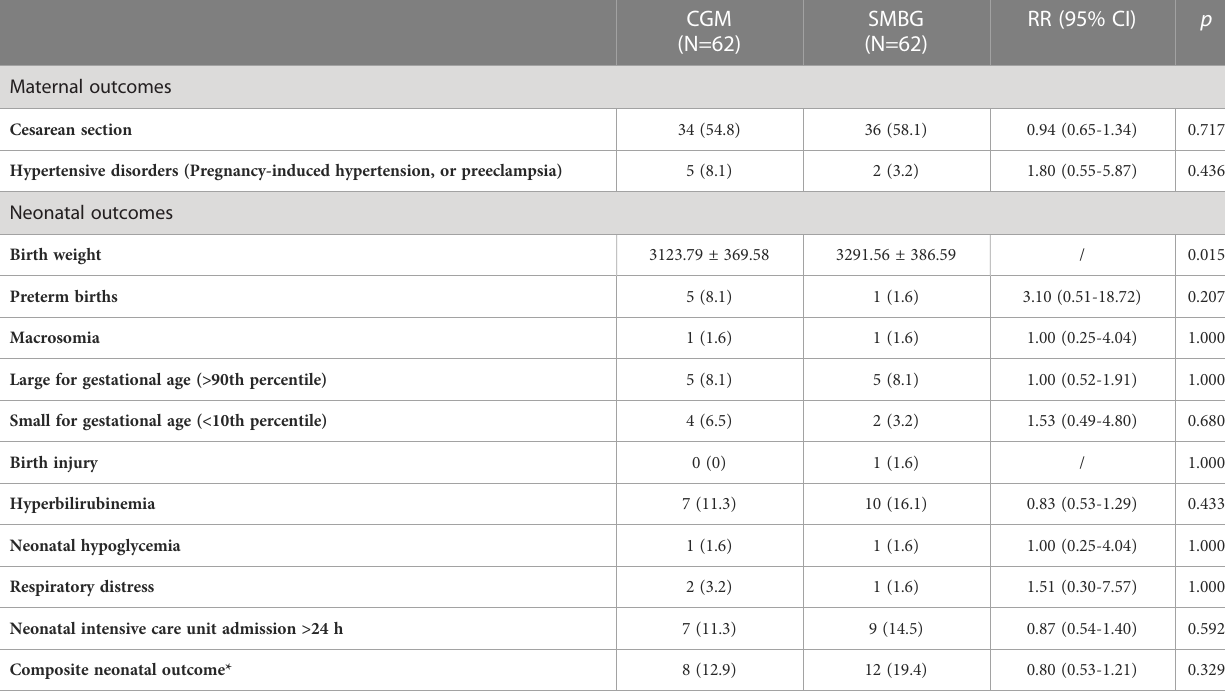
TABLE 4 Pregnancy outcomes of GDM